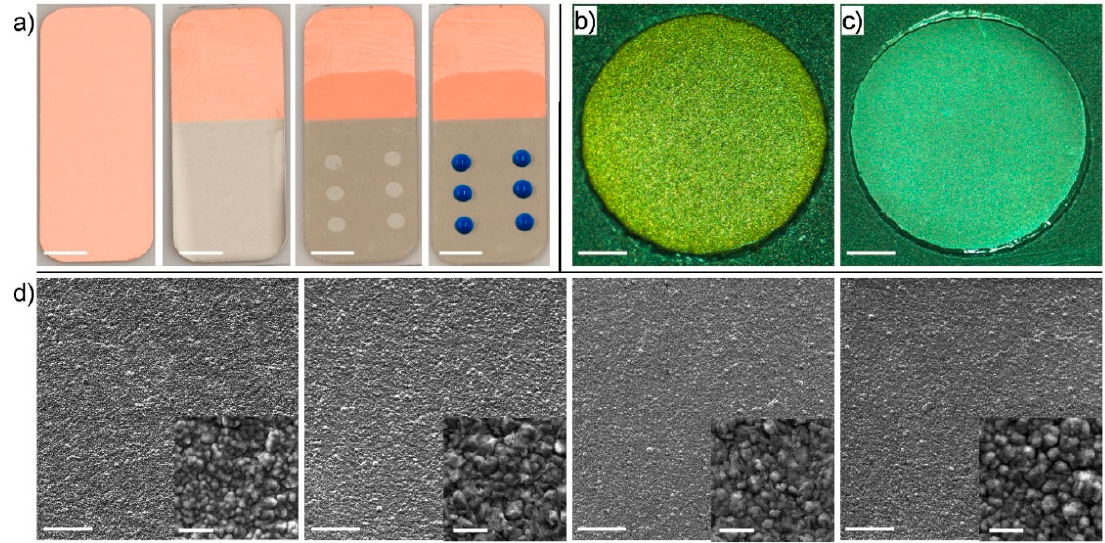
Figure 2. Electrodeposition of gold and silver through gel printing. ( a ) Substrate preparation, including nickel coating, mask lamination, and gel printing (scale bar = 7 mm); ( b , c ) electrodeposited layer of (b) gold and (c) silver (scale bar = 600 µm); ( d ) SEM images with insets of higher magnification for layers of Cu, Ni, Au, and Ag (from left to right) (scale bar = 100 µm; inset = 10 µm).